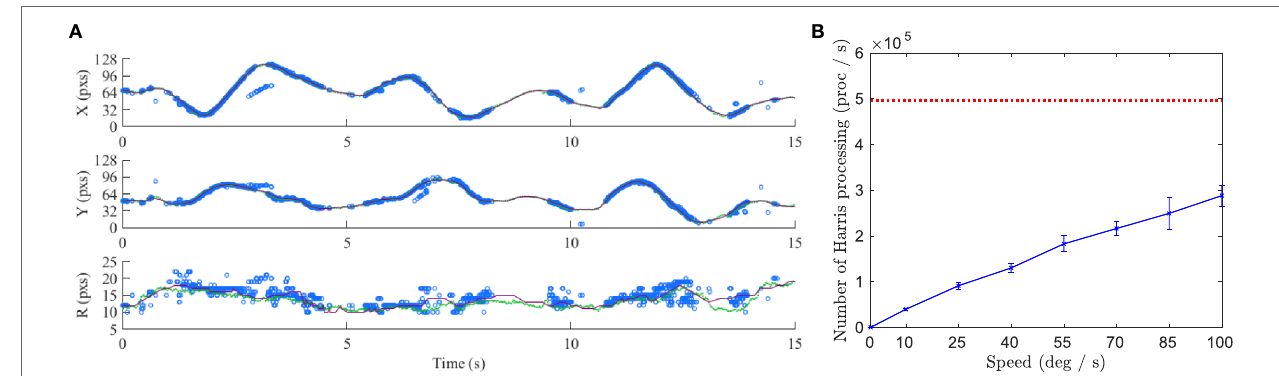
FIGURe 3 | The (A) tracking/detection accuracy of ev::vCircle (blue) and ev::vParticleFiler (green) compared to ground truth (black). Both algorithms can be used to control the iCub in gaze and grasping demonstrations. The (B) computation performance comparison between ev::vCorner and hypothetical frame-based Harris corner detection (red dashed line). A lower computational requirement is beneficial to resource contained on-line robotics. These figures can be generated using the scripts found in the datasets